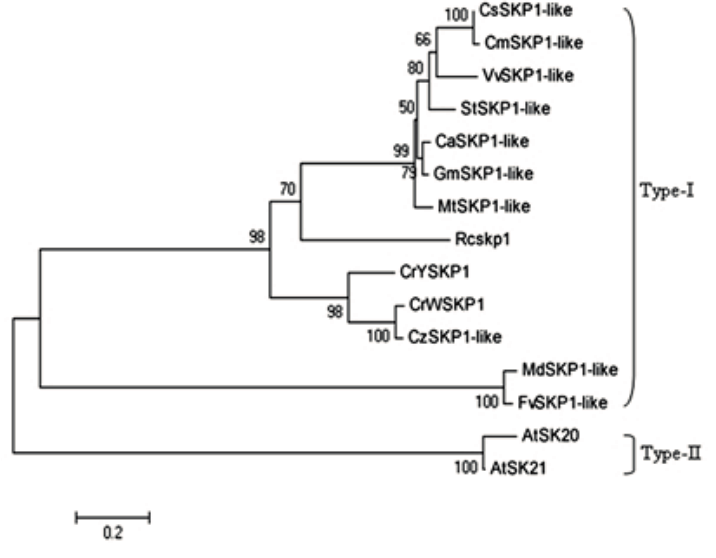
Figure 2. Phylogenetic relationship of CrWSKP1 and CrYSKP1 with SKP1-like genes from other plants. The numbers of each interior branch are the percentage bootstrap values